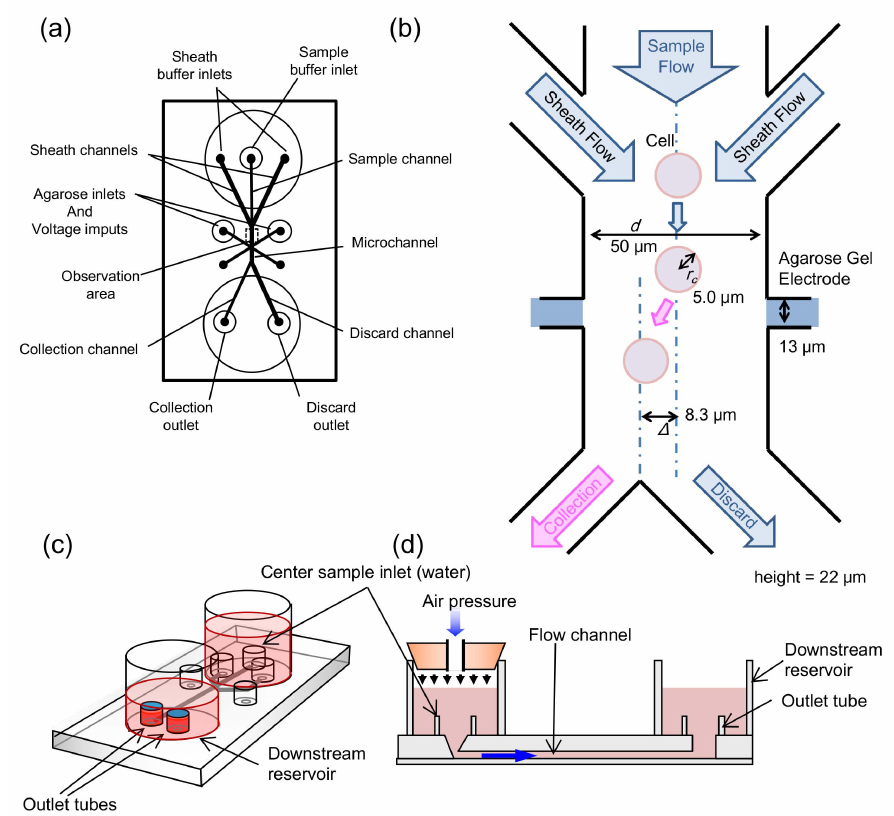
Figure 2. Three-inlet two-outlet agarose gel electrode microfluidic chip design. ( a ) schematic image of the top of the chip (same design as we reported in a previous paper [20]); ( b ) schematic drawing of the cell analysis and site of separation of the microfluidic pathway; ( c ) bird’s eye view of the whole chip design, and ( d ) a cross-sectional image of the